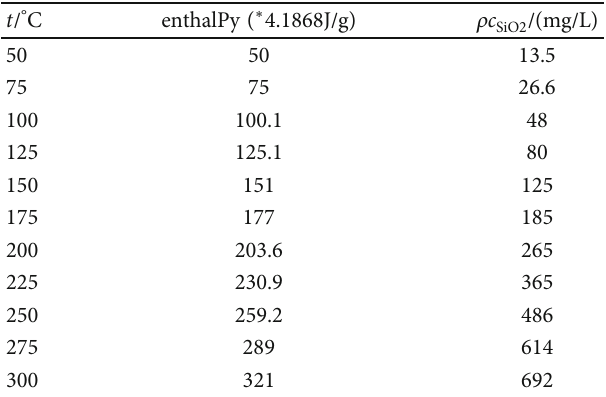
Figure 8: Relationship between Cl and B contents in the study area. Table 8: Relationship between water temperature, enthalpy, and mass concentration of SiO 2